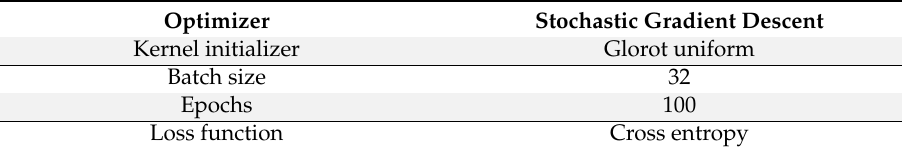
Table 4. Training